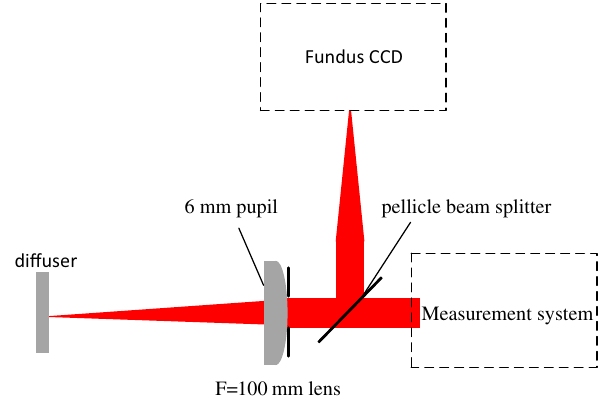
Fig. 3. Illustration of the chromatic-aberration eye model and fundus observation system.